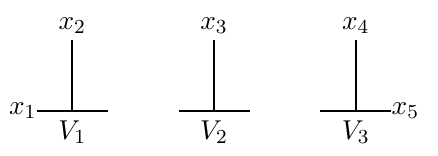
Figure 8 . OPE vertices for the 5-point block of figure